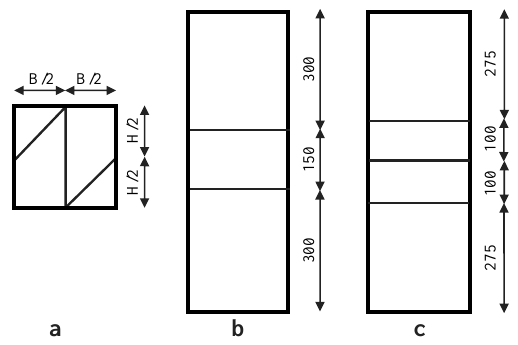
Fig. 7. Details of the stiffened CFSC stub columns: (a) arrangement of bar stiffeners in the column; (b) typical elevation of column with 2 bar stiffeners and spacing of 150 mm; (c) typical elevation of column with 3 bar stiffeners and spacing of 100 mm, (unit: mm)